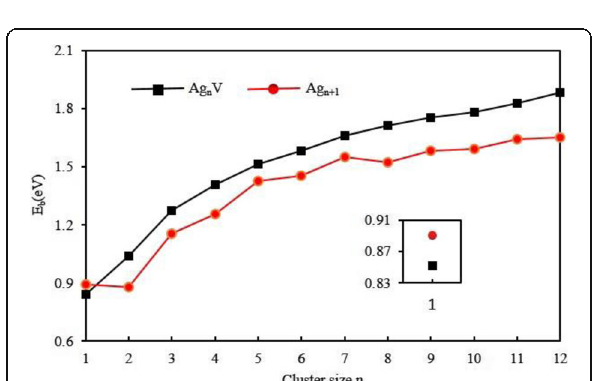
Fig. 5 The averaged binding energies of the lowest energy Ag n +1 and Ag n V ( n = 1 – 12)